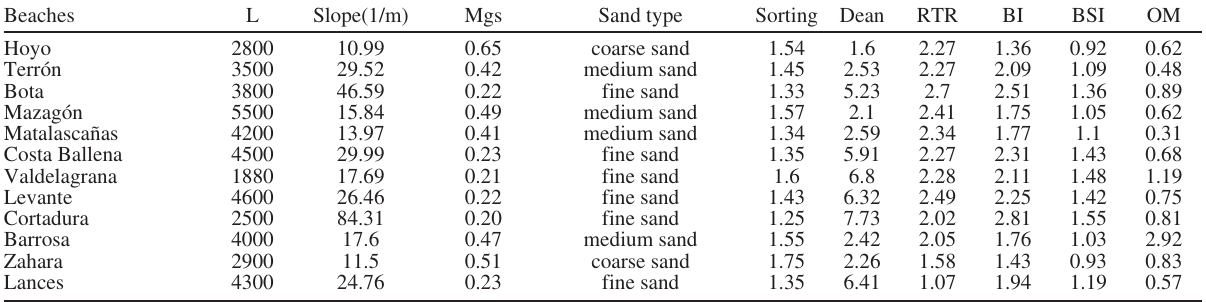
Table 1. – Physical characterization of sampled beaches. L, beach length (m); Mgs, median grain size (mm); OM, organic matter content (%); RTR, Relative tide range; BI, beach index; BSI, beach state index. Beaches L Slope(1/m) Mgs Sand type Sorting Dean Hoyo